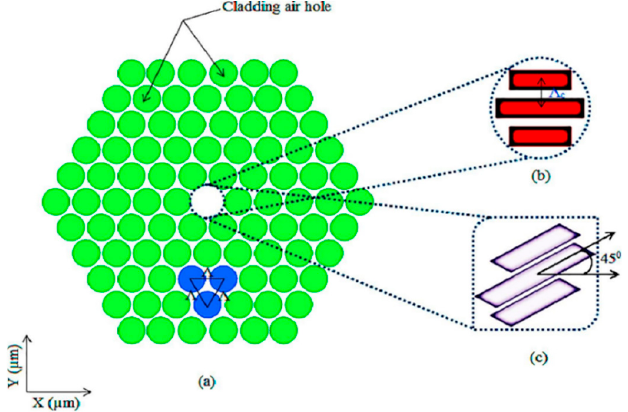
Figure 8. Schematic end face view of proposed PCF; ( a ) cladding region; ( b ) core region with 0 ◦ rotation; ( c ) core region with 45 ◦ rotation. Reprinted with permission from [84].